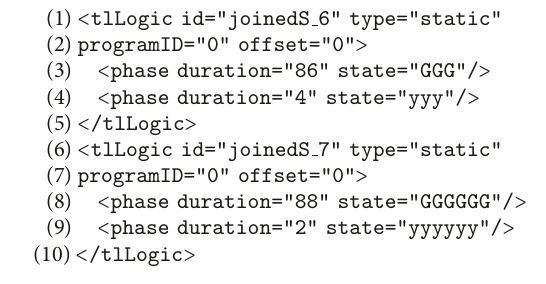
Algorithm 1: Errors in the TLS program.